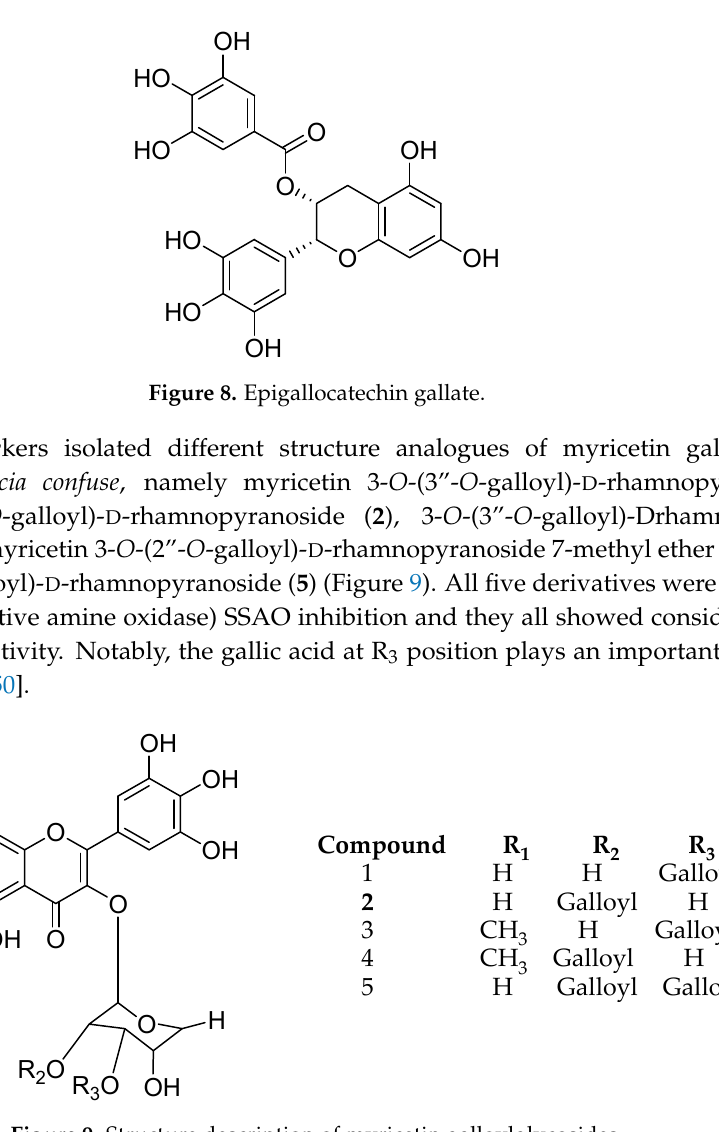
OH Figure 11. Genistein. Naringenin (Figure 12) was collected from the ethanolic extract of Mentha aquatica L . via by bioactivity-guided fractionation on preparative TLC [54]. The MAO inhibitory IC 50 values by naringenin were calculated as 340 ± 30 M for the homogenate of rat liver mitochondrial fraction, 288 ± 18 M was calculated for MAO-B and for MAO-A 955 ± 129 M. However the MAO inhibitory potential of was not more than quercetin.